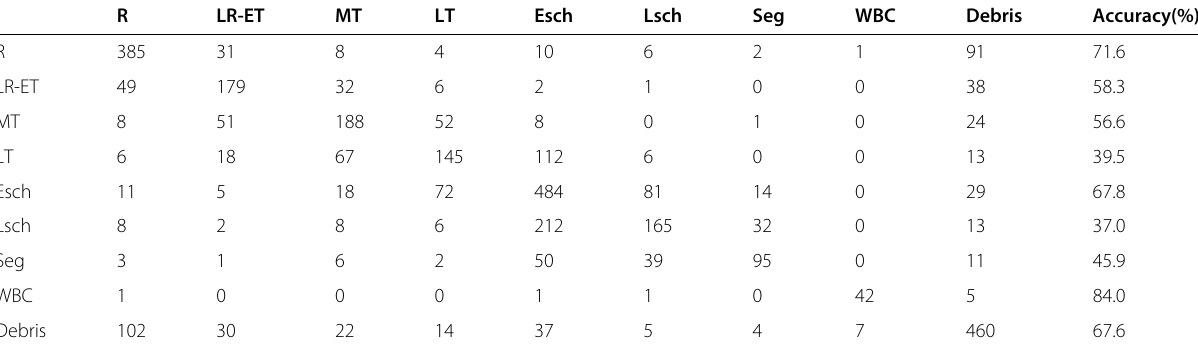
Table 4 Average confusion matrix with overall accuracy of 58.8% R